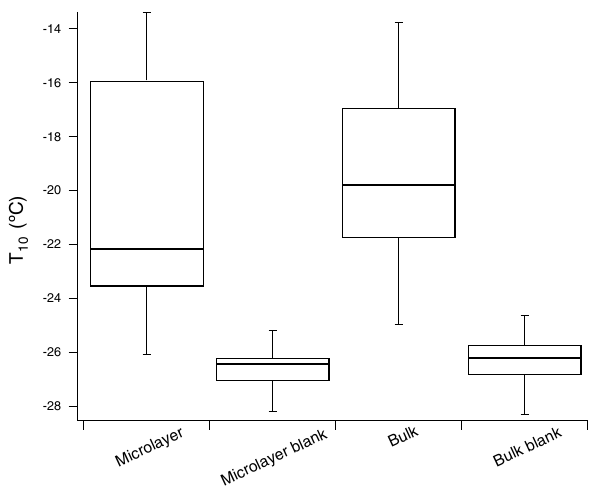
Figure 3. Temperature at which 10% of droplets had frozen ( T 10 ) for microlayer and bulk seawater samples. All data have been cor- rected for freezing point depression. Boxes represent the 25th, 50th, and 75th percentiles, and whiskers represent the minima and max-